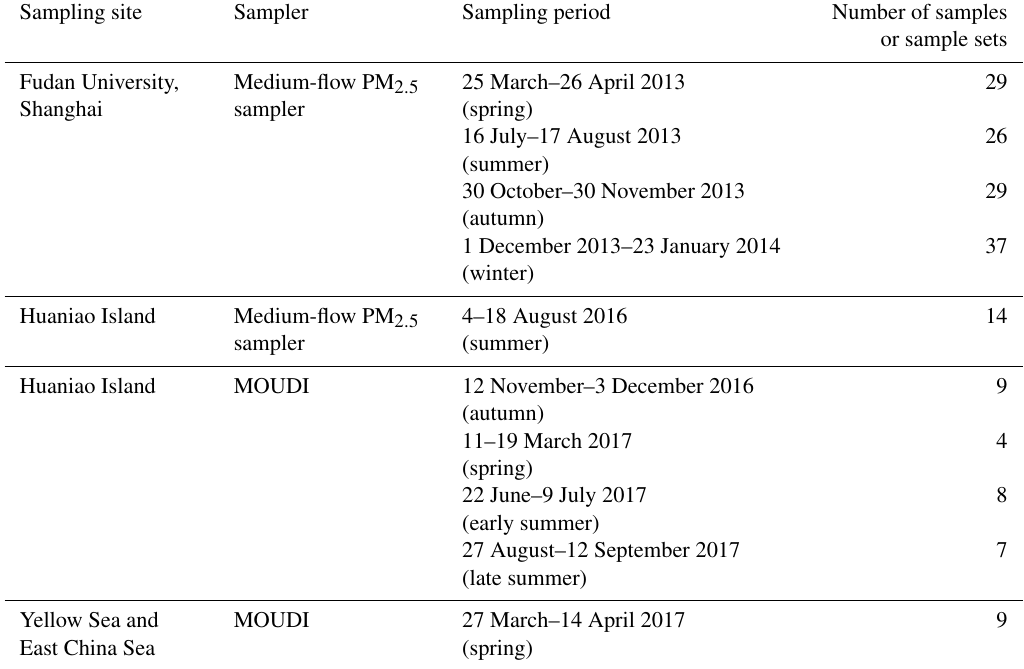
Table 1. Summary of sampling information from the different